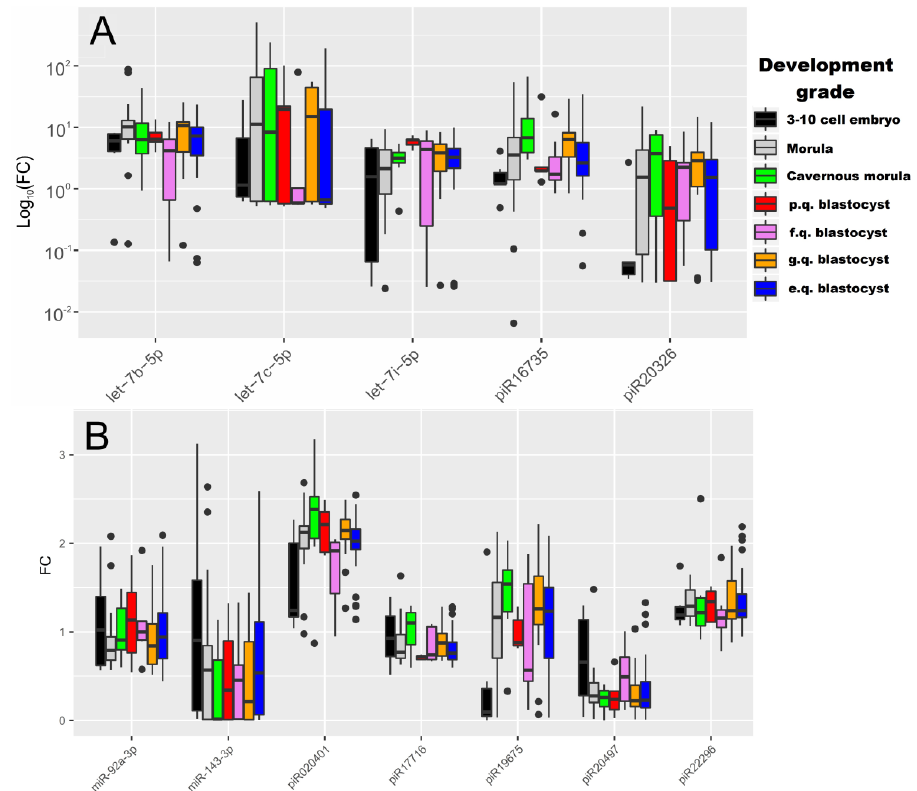
Figure 3. sncRNA expression level fold change in the culture medium of embryos of di ff erent development grade. ( A ) sncRNA expression level fold change (FC) with values varying from 0.01 to 400 (data are presented on a logarithmic scale). ( B ) sncRNA expression level FC with values varying from 0.1 to 3.5 (data are presented on a linear scale). E.q.—excellent quality, g.q.—good quality, f.q.—fair quality, p.q.—poor